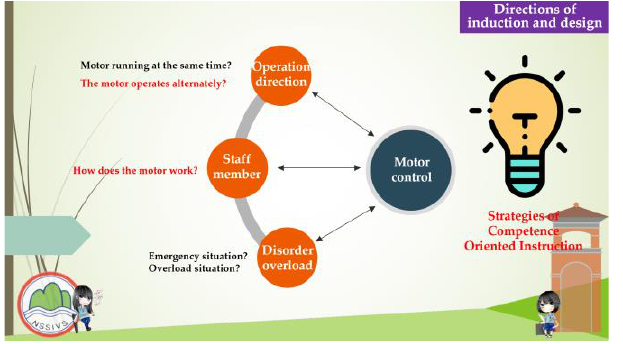
Figure 4. Competency-based instructional materials used in this research. These involve the ideas of induction and design.